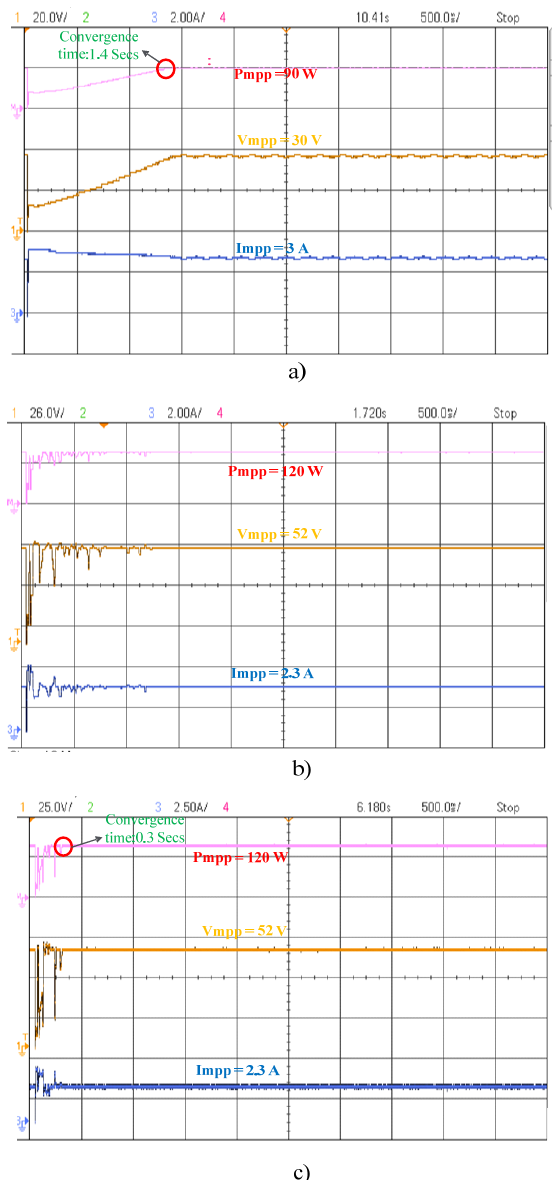
Figure 22. Experimental result for Pattern 6 under partial shading ( a ) P&O, ( b ) PSO, ( c )